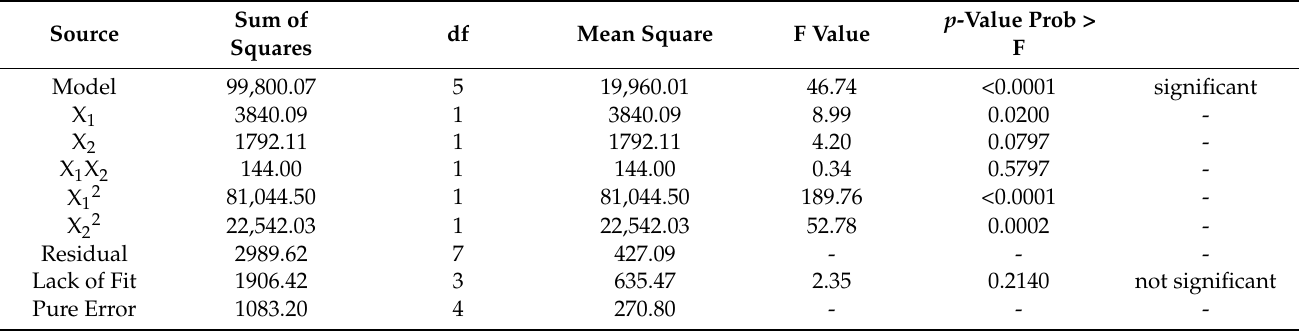
Table 4. ANOVA for response surface quadratic